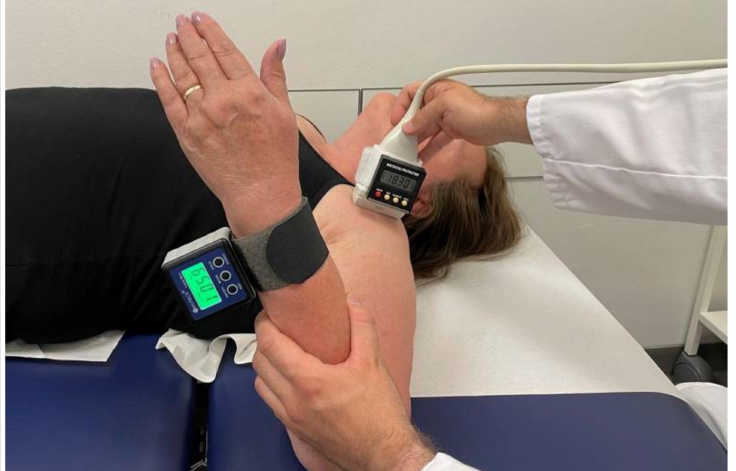
Figure 2. Sonographically assisted indirect measurement of humeral torsion. The angles determined are each given a positive sign if the corresponding protractor is inclined inward/caudal during the measurement and a negative sign if the protractor is inclined outward/cranial during the measure- ment. As the corresponding protractor attached to the transducer is inclined outward/cranial in this case, a negative sign must be given to this determined angle. As also the vertically positioned forearm protractor was zeroed on the horizontal table plane before attachment, its measured angle has to be subtracted from 90 ◦ to obtain the actual forearm angle. In this case, the forearm protractor displayed 65.01 ◦ , which results in 24.99 ◦ as actual forearm angle (90 ◦ –65.01 ◦ ). All values were rounded for further calculation.